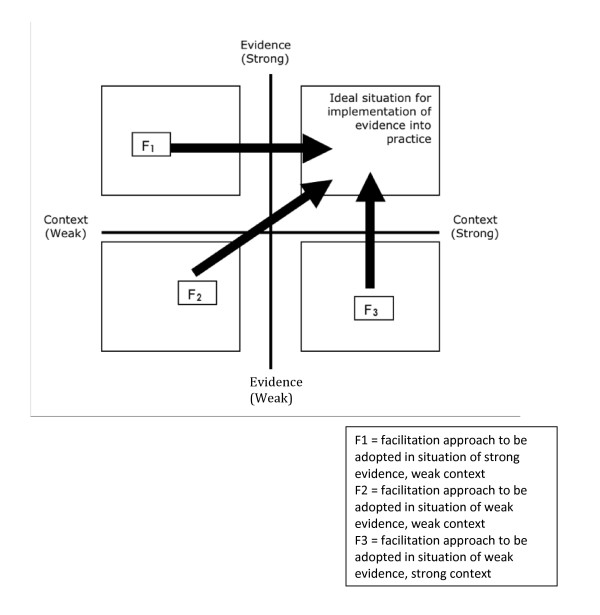
The PARIHS Conceptual Framework [28].